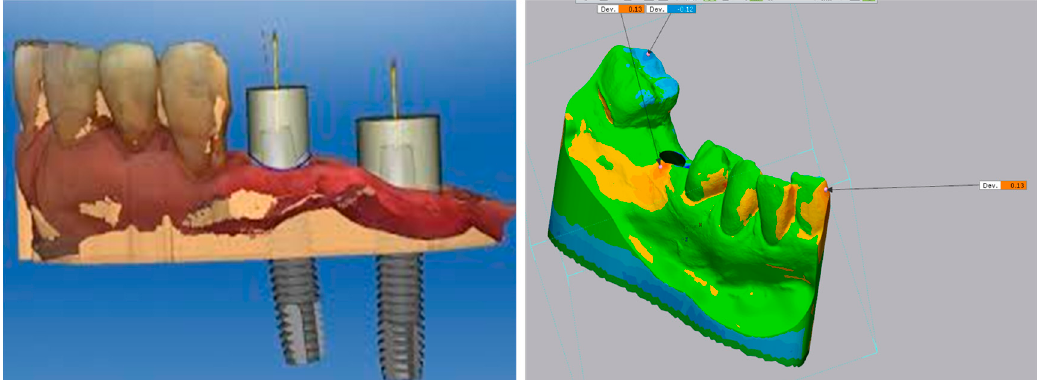
Figure 3. A 3D printed STL showing a difference of less than 0.13 mm of model accuracy of the planned position in FH surgical technique.